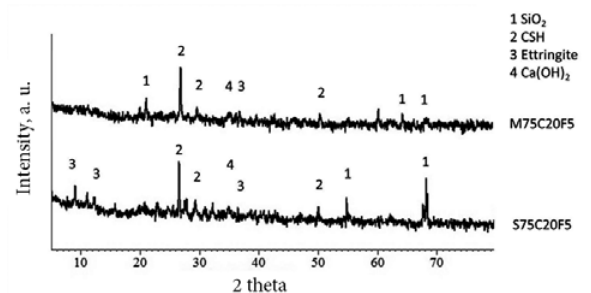
Fig. 4. XRD patterns of S/S treated marine mud and S/S treated sediment after 28 days of curing.